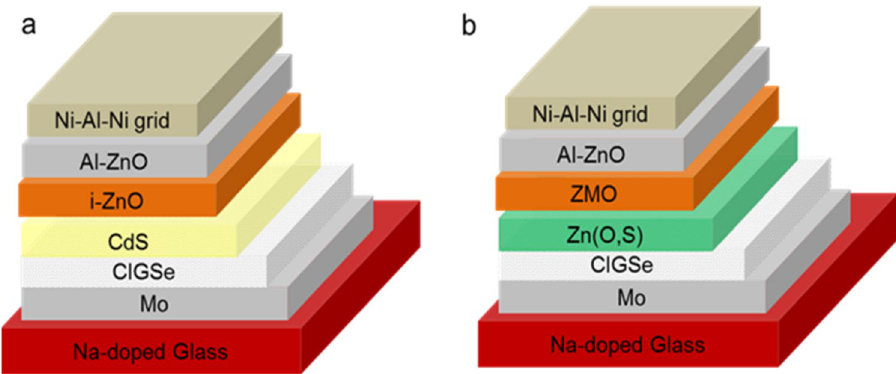
Fig. 13 a CIGSe device struc- ture with CdS as buffer layer ( η = 21.7%) [29]. b Record efficiency CIGSe device struc- ture of η = 21% with Zn(O,S) as buffer layer